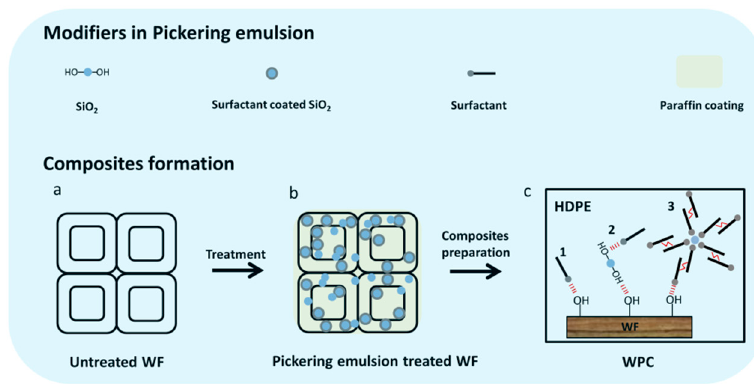
Figure 12. Schematic illustration for interactions in the composites treated by Pickering emulsion.